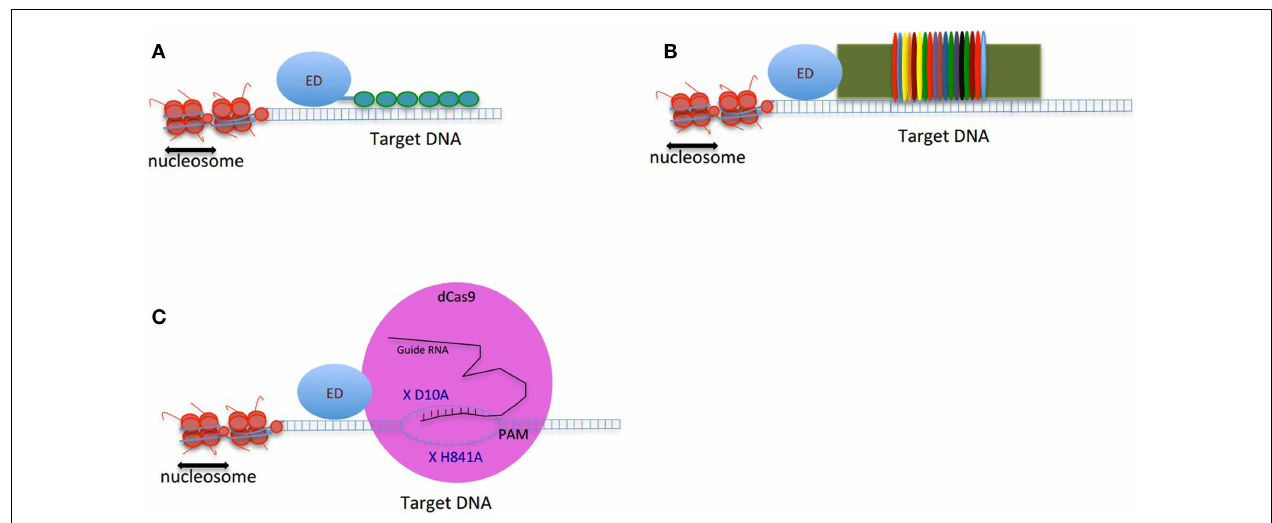
(B) are representing tandem repeats ofTALEs. In (C) , the pink large circle represents dCas9 protein. X D10A and X H840A are two mutations deactivating endonuclease activity of dCas9.The guide RNA is shown in black.The target binding site of guide RNA is located upstream of PAM.The small vertical lines between guide RNA and the target region of DNA are showing the hydrogen